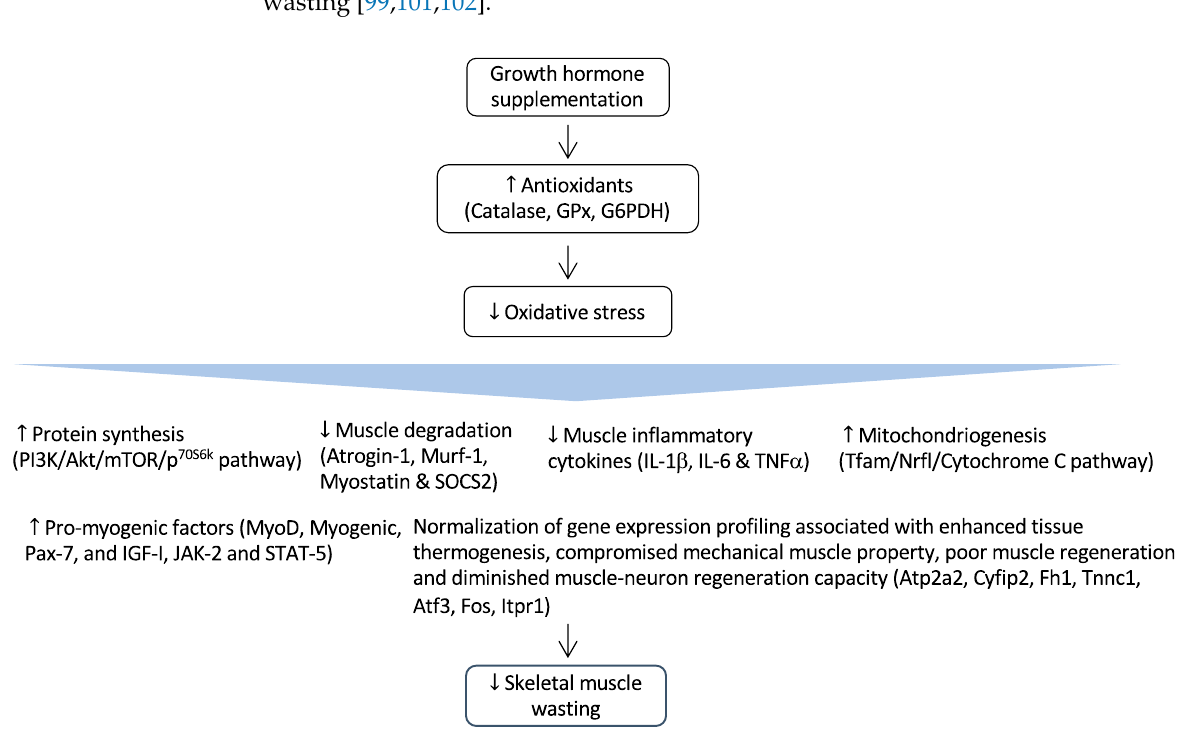
Figure 2. Regulation of GH and its effects in CKD-associated muscle wasting. GH supplementation activates the expression of important endogenous antioxidant enzymes such as catalase, glutathione peroxidase (GPx), and glucose-6-phosphate-dehydrogenase (G6PDH). As a result, it reduces muscle wasting by attenuating oxidative damages to critical cellular structures. Arrow in the figure indicates the beneficial effects of GH supplementation on skeletal muscle wasting.